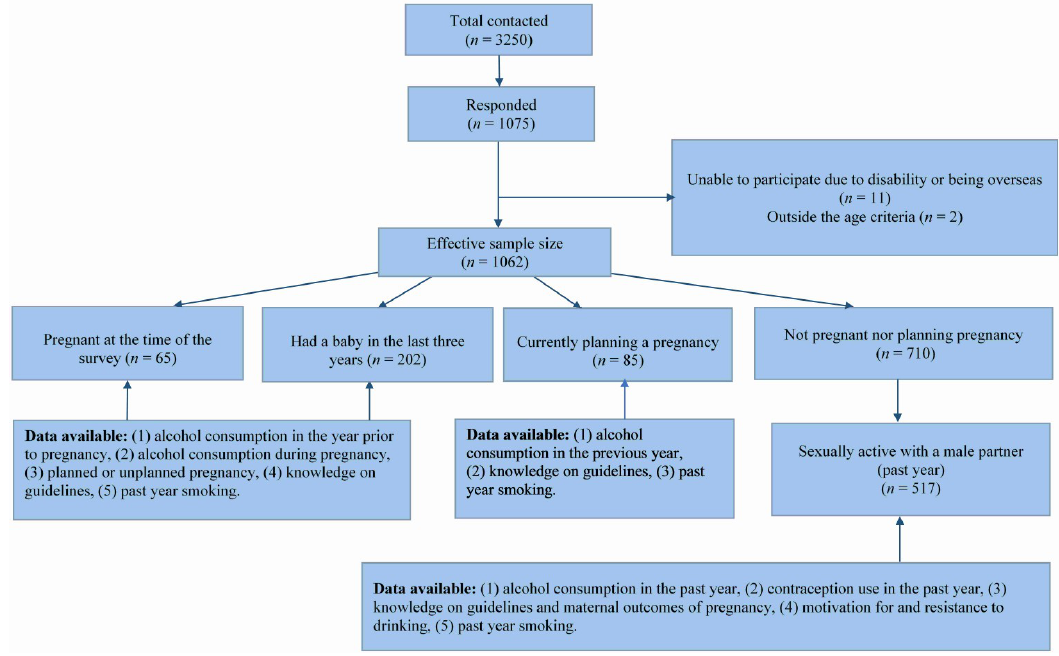
Figure 1. Schematic representation of the study sample and data available according to maternal status.